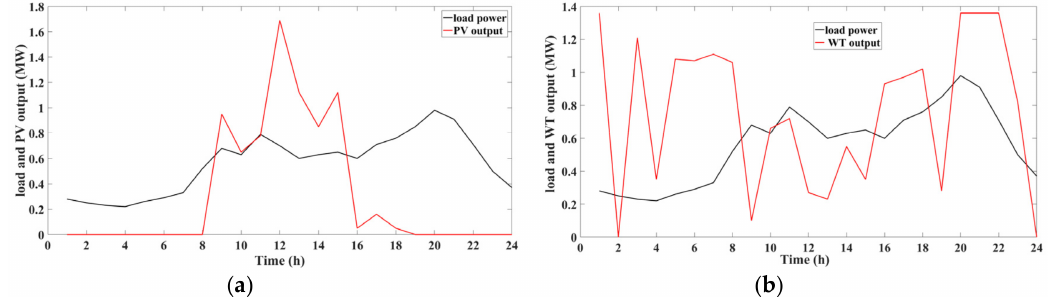
Figure 2. Relationships between resources and load. ( a ) Relationships between load and photovoltaic power of TS 1 and TS 2. ( b ) Relationships between load and wind power of TS 3 and TS